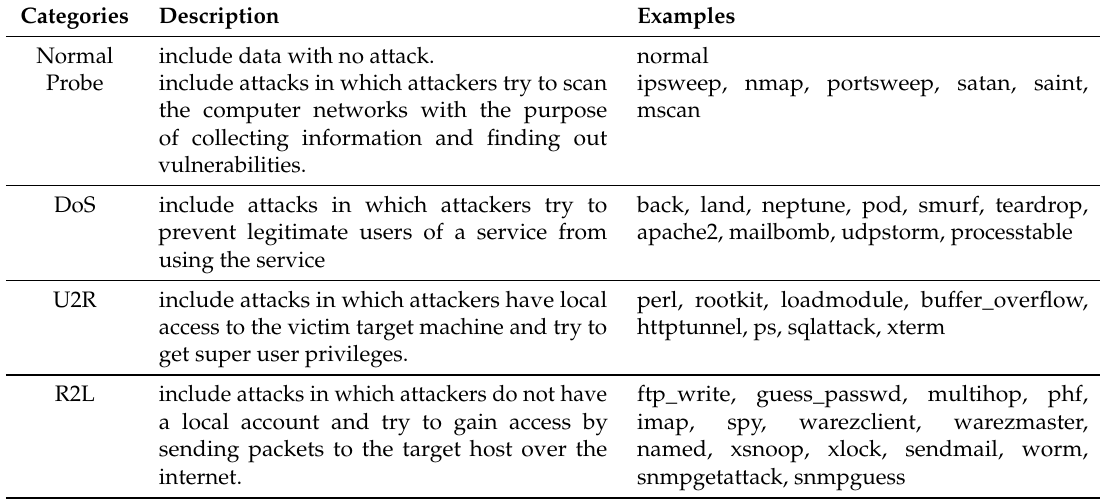
Table 2. Categories of the NSL-KDD dataset